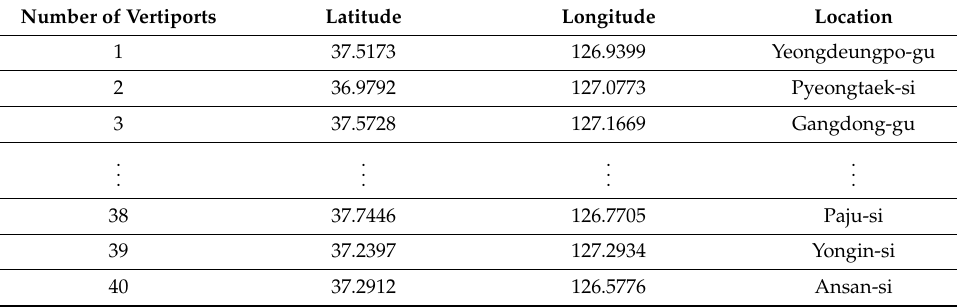
Table 4. Location of repositioned